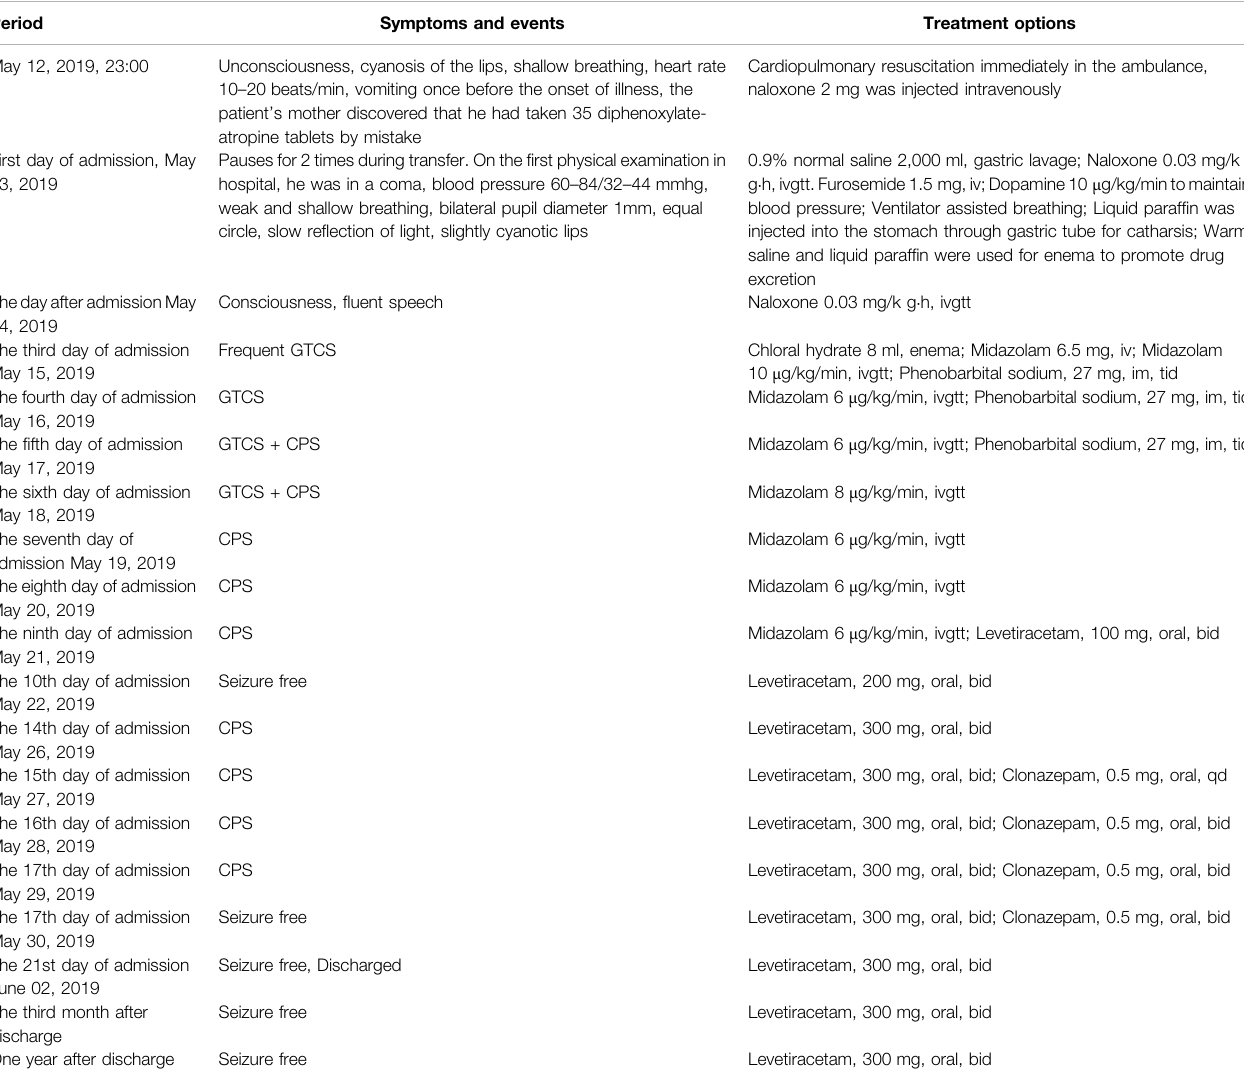
TABLE 1 | Clinical features, treatment options, and outcome in this child. Period Symptoms and events Treatment